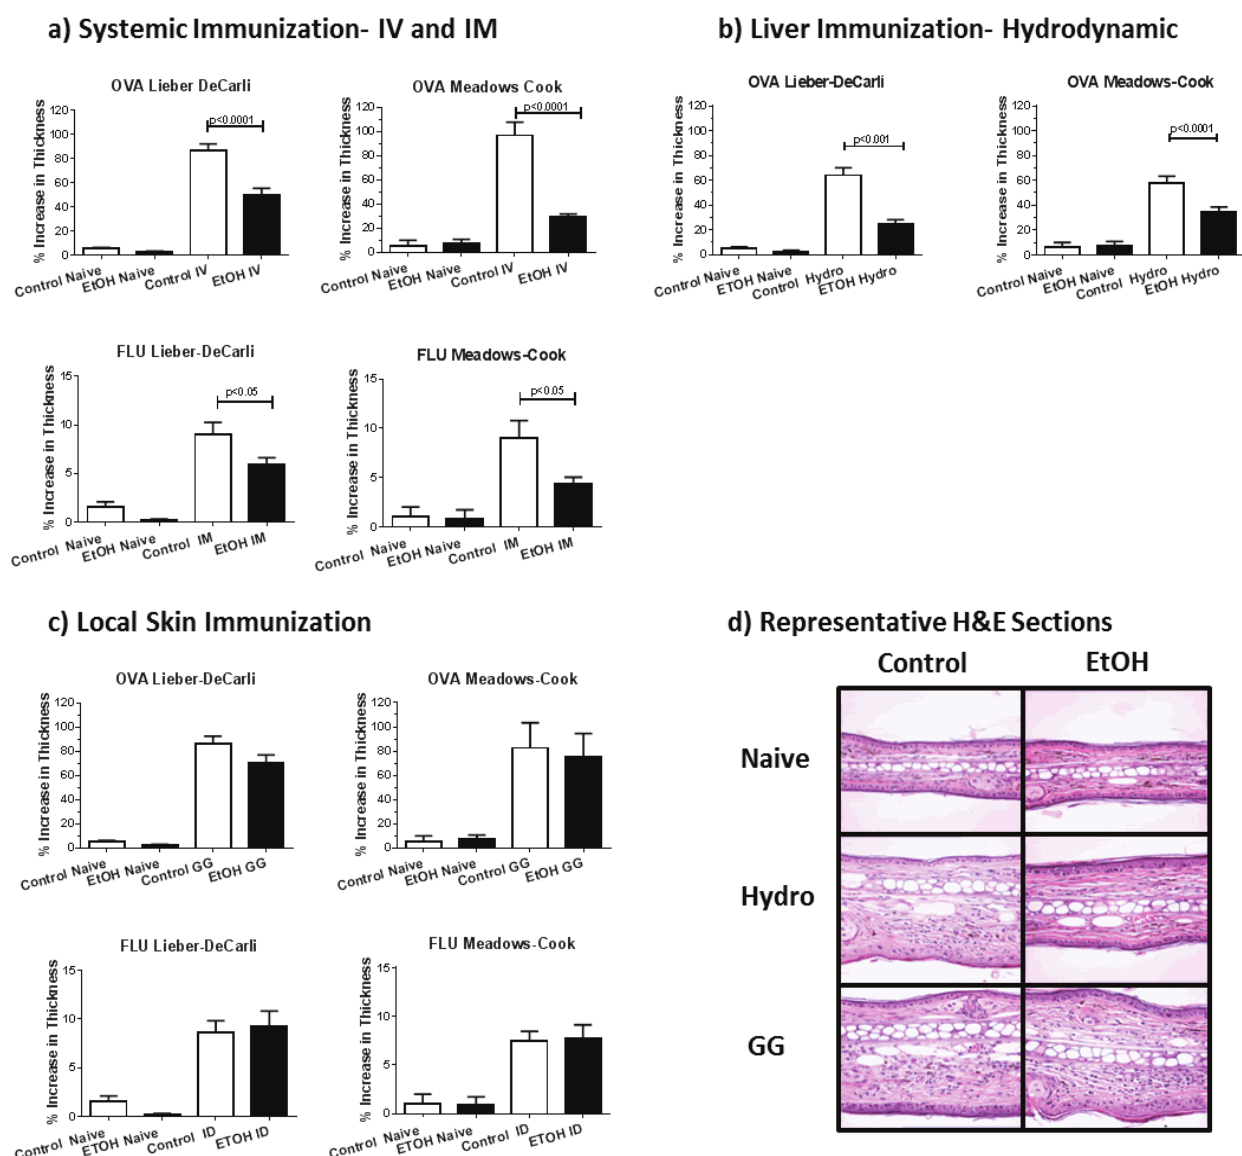
Figure 3. Skin Immunizations Obviate EtOH Induced DTH Inhibition. DTH responses are reported for groups of mice fed by either LD or MC ETOH feeding protocols as indicated after ( a ) systemic; ( b ) liver or ( c ) skin immunization with either OVA pDNA or FLU protein vaccine via intravenous, intramuscular, hydrodynamic, biolistic, or intradermal routes of administration as indicated. DTH responses were elicited and measured as ear or footpad swelling as defined in the methods section. Data are presented as % increase in thickness (ear for OVA, footpad for FLU). LD and MC have equivalent DTH responses; ( d ) representative H and E stained ear sections after OVA immunization and